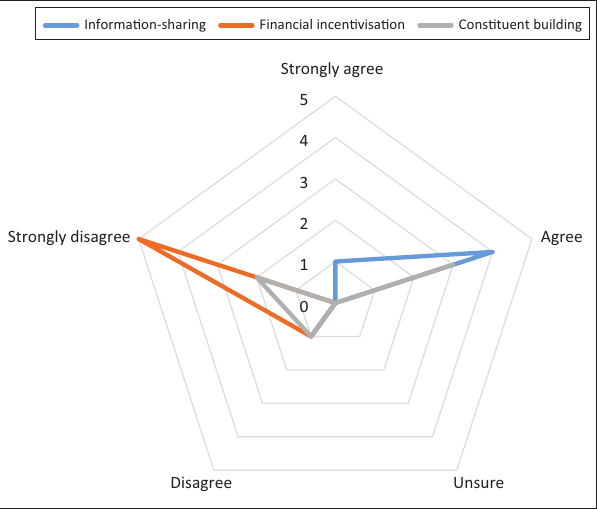
FIGURE 3: Strategy